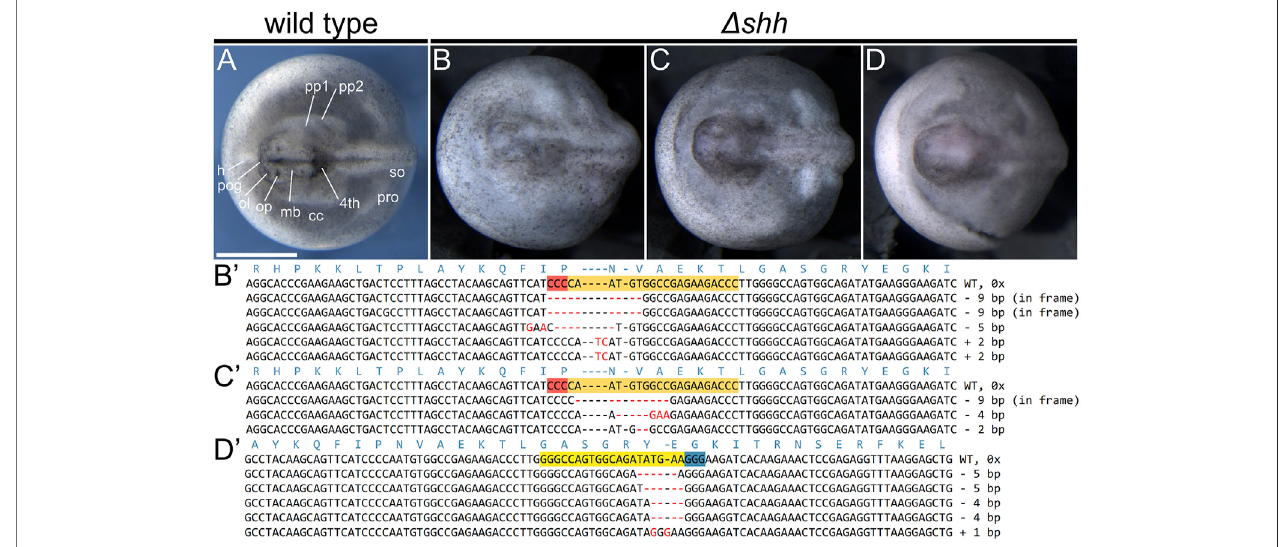
FIGURE 3 | Phenotypes and genotypes of Δ shh sterlet larvae. Dorsal views of st. 28 larvae with anterior to the left. Wild type [WT; (A) ] and mutant (B – D) embryos andtheirmutantalleles (B 9 – D 9 ) .TheCRISPRtargetsitesarehighlightedinorangewithredPAMonthereversestrandsequences,whiletheyareyellowwithbluePAMon the forward strand. The red dashes and letters represent deletions, insertions, and polymorphisms relative to the WT sequence. Mutations in (B 9 ,C 9 ) were introduced using shh sgRNA 1, while the mutations in (D 9 ) resulted from injections of shh sgRNA 2. No WT sequences were identi fi ed in any of the individuals showing shh phenotype(sixgenotypedindividualsintotal).Themutantembryoin (B) wasscoredasmissingpre-oralgut,opticandolfactoryplacodes,forebrain,midbrain,partofthe hindbrain, and pharyngeal pouches and with underdeveloped pronephros. The mutant embryo in (C) is missing pharyngeal pouches and has deformed forebrain and midbrain. The mutant embryo in (D) was identi fi ed as missing pharyngeal pouches and somites, the entire head is underdeveloped. Fourth — fourth brain chamber of hindbrain, cc — coelomic cavity, h — heart, mb — midbrain, ol — olfactory placode, op — optic placode, pog — pre-oral gut, pp — pharyngeal pouch, pro — pronephros, so — somites. Scale bar represents 1